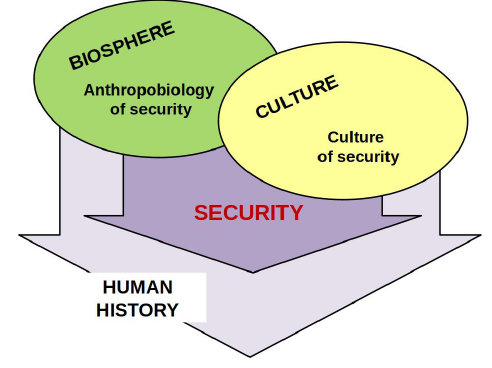
Figure 3. Human activity and security